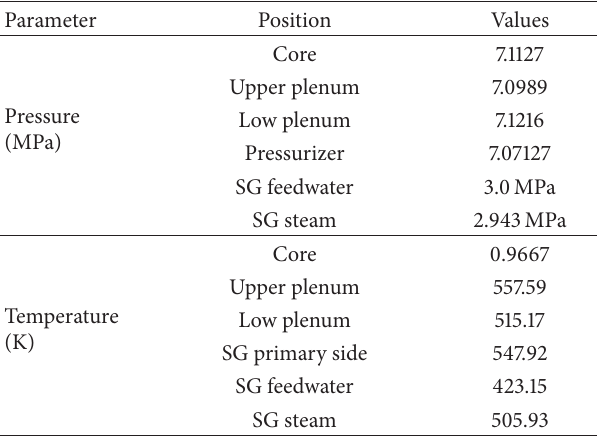
Table 2: RELAP5 calculation values of pressure and temperature in different positions.